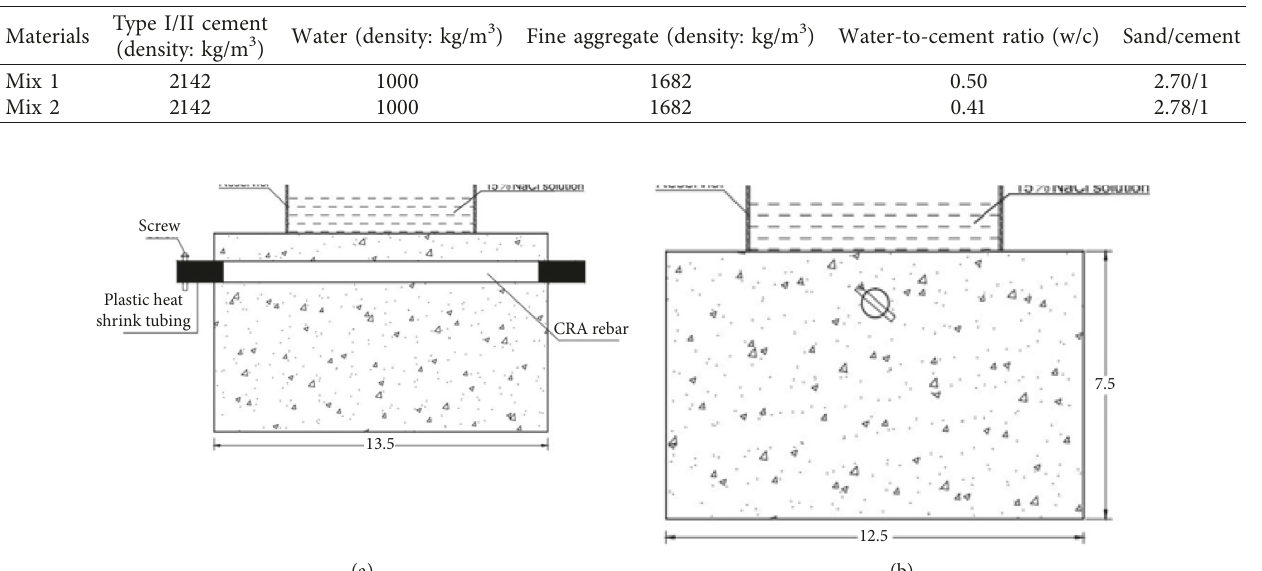
Table 2: Details of mortar mixes.